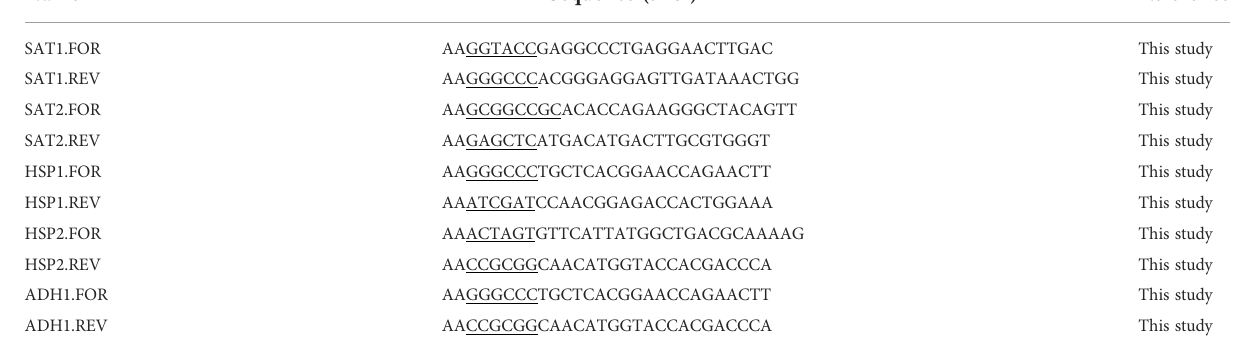
TABLE 3 Oligonucleotide primers used for cloning in this